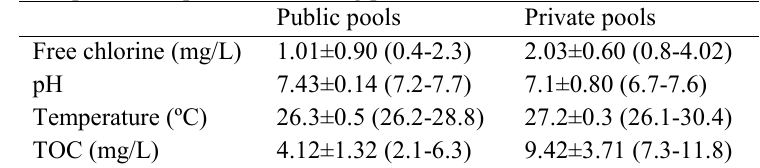
Table 1. Concentrations of physicochemical parameters in water samples from public and private swimming pools Public pools Private pools